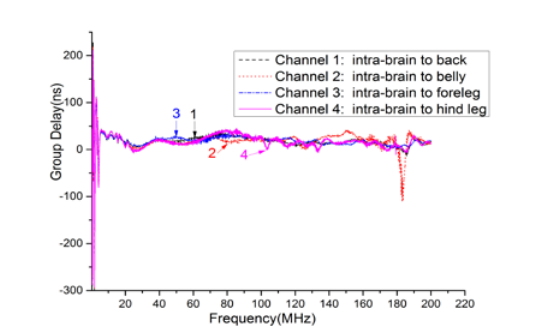
Figure 6. The characteristics of group delay in four channels.